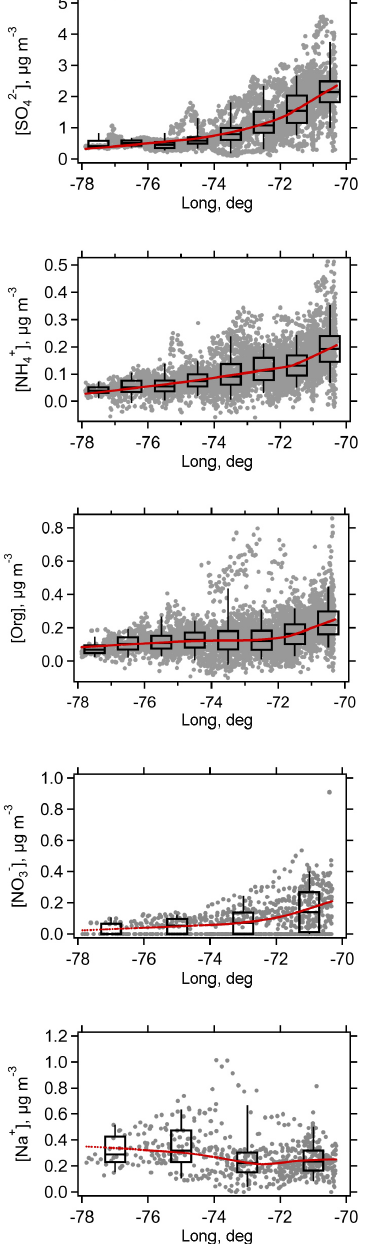
Figure 4. Composite longitudinal dependence of below-cloud (BC) aerosol concentrations determined on the G-1 for the entire VO- CALS mission. Box plots (black) and LOWESS smooth (red) are overlaid on individual data points (grey).